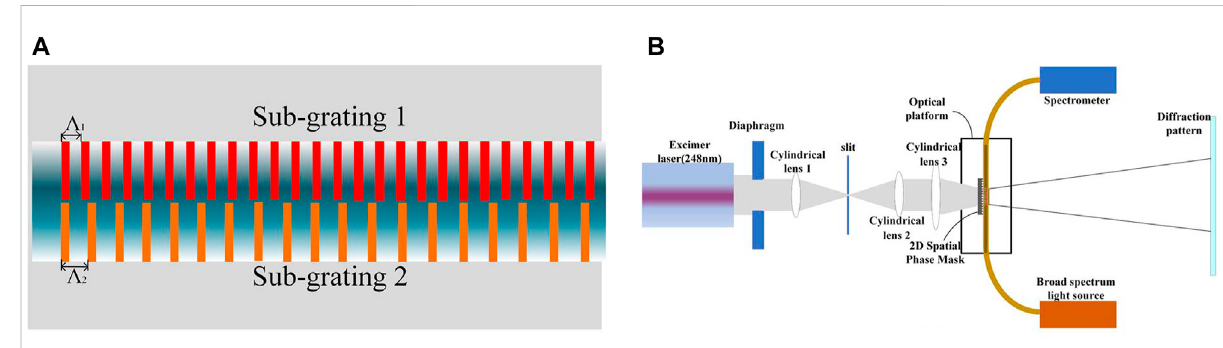
FIGURE 1 The schematic diagram for thefabricating system of 2D FBG. (A) Schematicdiagram of thegrating distributionof the2D FBG(viewedalong the longitudinal direction). (B) Schematic diagram of the optical path of the 2D fi ber grating fabricating system (viewed from